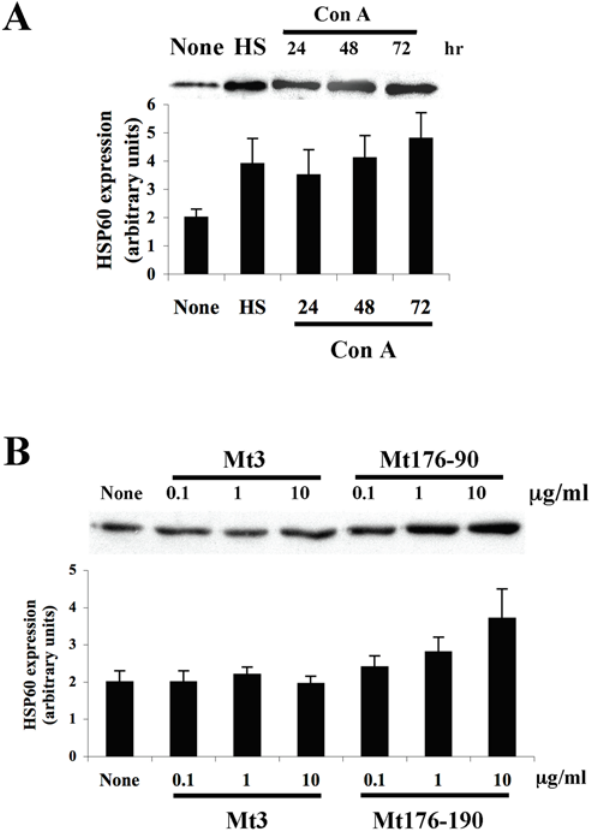
Figure 3. T-cell activation up-regulates cellular levels of HSP60. A. LNC were stimulated with Con A for 24, 48 or 72 hr, subjected to a 30 minutes 42 u C heat shock (HS) or kept at 37 u C (None). Cell lysates were prepared and HSP60 expression was analyzed by western blot with specific antibodies, and quantified (in arbitrary units). B. A2b T-cells were stimulated with various concentrations of the target peptide Mt176-90, a control peptide (Mt3) for 72 hr, or with medium alone (None). Cell lysates were prepared and HSP60 expression was analyzed by western blot with specific antibodies, and quantified (in arbitrary units). Two independent experiments produced similar